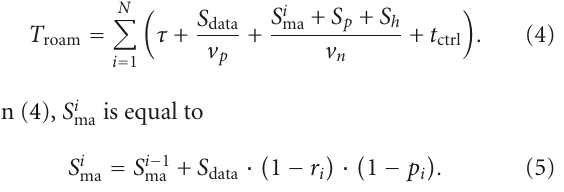
(3) Find the next hop node to route an MA along the entire path from sink to source, source to source, and source to sink. Dispatched by the sink, an MA migrates to First- Src in the same manner as a reinforcement message is forwarded in original DD. When the MA migrates among target sources, its next hop node will be de- cided according to current node’s ToSourceEntry . The MA will return to the sink using the reinforced path (e.g., path D -7-5-2- E in Figure